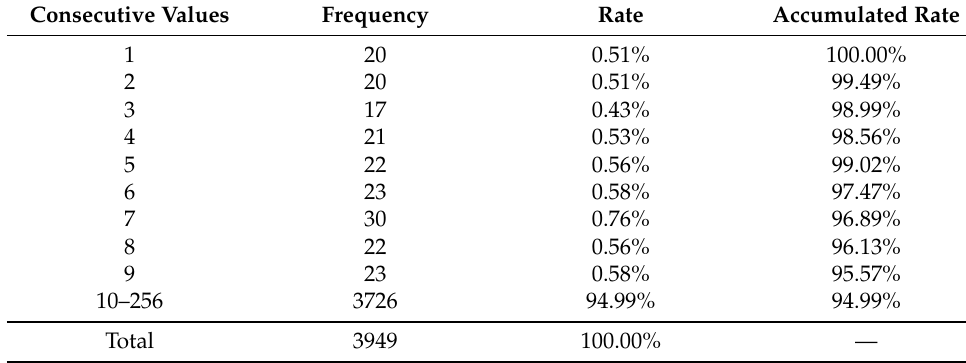
Table 3. Value consecutiveness of one-pixel